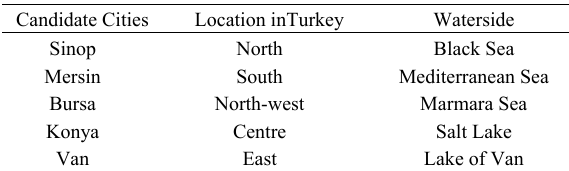
Table 4. The characteristic properties of the candidate cities.